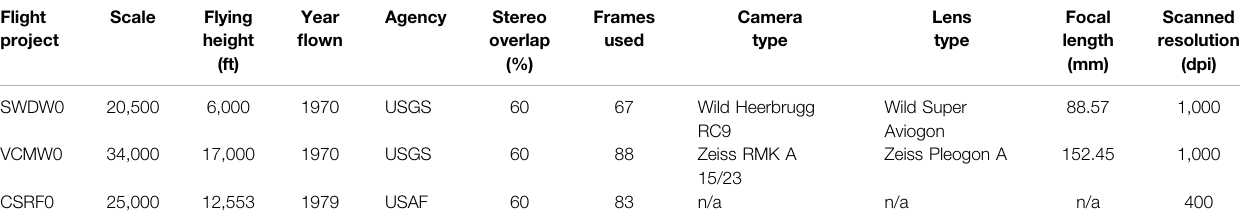
TABLE 1 | Details of aerial photograph projects used to produce a 2-m DSM in Agisoft Metashape and LAStools. Flight